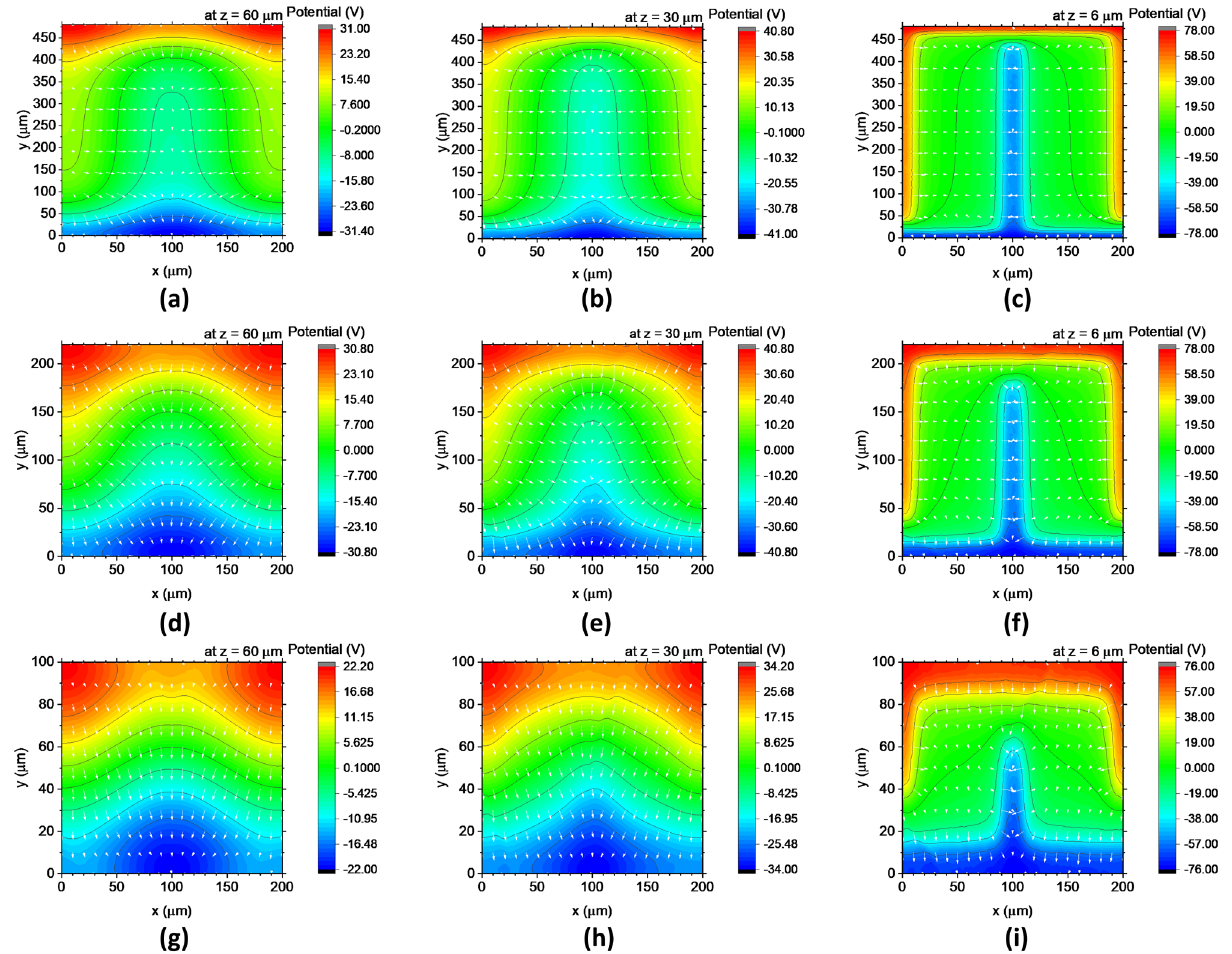
Figure 4. Potential and electric field distributions in the horizontal sections of the unit cells with dimension of x = 200 µm and y = ( a – c ) 480 µm, ( d – f ) 200 µm, and ( g – i ) 100 µm in the in-plane state of 100 V. ( a ), ( d ), and ( g ) are at z = 60 μm, ( b ), ( e ), and ( h ) are at z = 30 μm, and ( c ), ( f ), and ( i ) are at z = 6 μm. The white arrows in each graph indicate relative electric